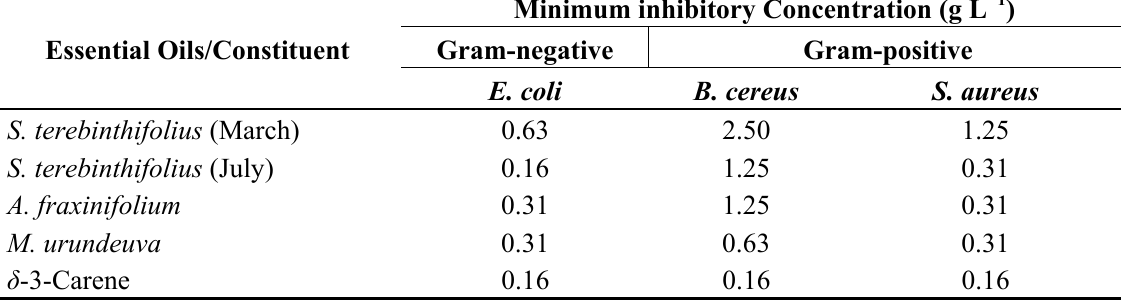
* Means followed by same capital letter; lines or minor letter columns are not different by Scott-Knott’s test at p 5%. Table 3. Minimum inhibitory concentration (MIC) of bacterial growth for the essential oils extracted from leaves of the species A. fraxinifolium , M. urundeuva , Schinus terebinthifolius and the monoterpene δ